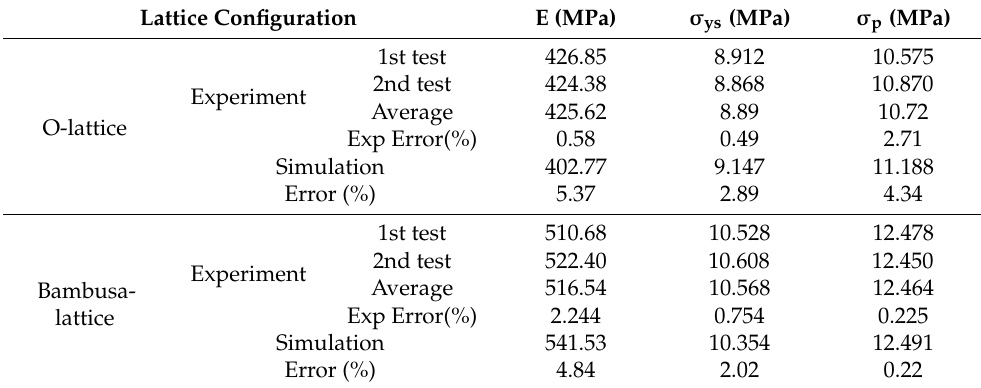
Figure 7. Comparisons of the stress–strain curves and deformation processes from experiments and simulations: ( a , c ) O-lattice samples and ( b , d ) Bambusa-lattice samples. Table 4. Mechanical properties of the O-lattice and Bambusa-lattice